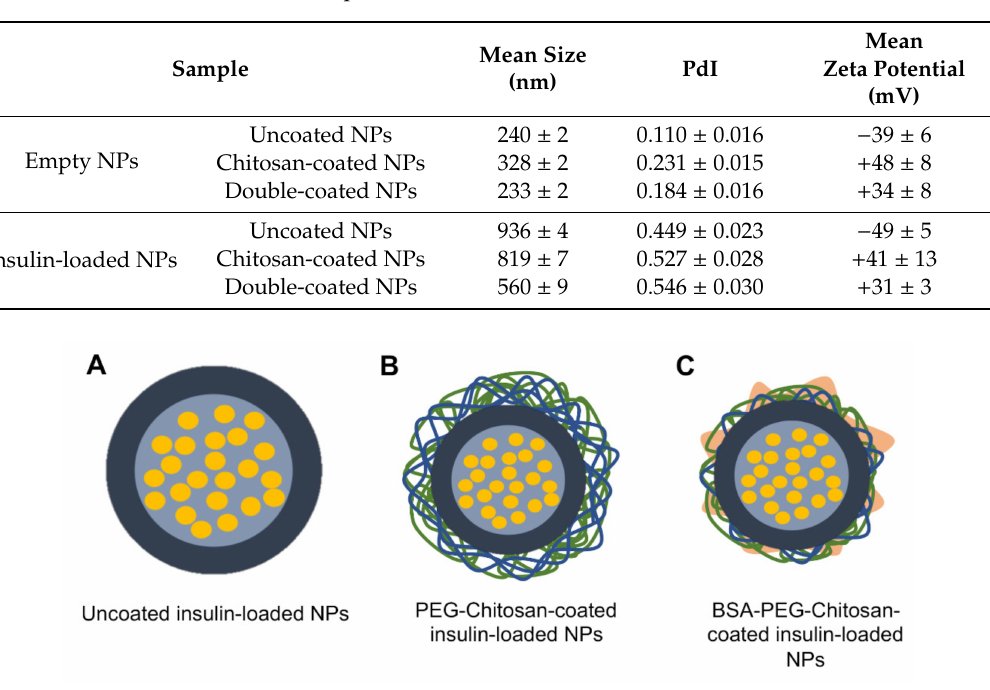
Table 1. Mean size, PdI and zeta potential throughout the di ff erent steps in formulation, for both empty and insulin-loaded NPs. All data is presented as mean ± SD (n = 3).